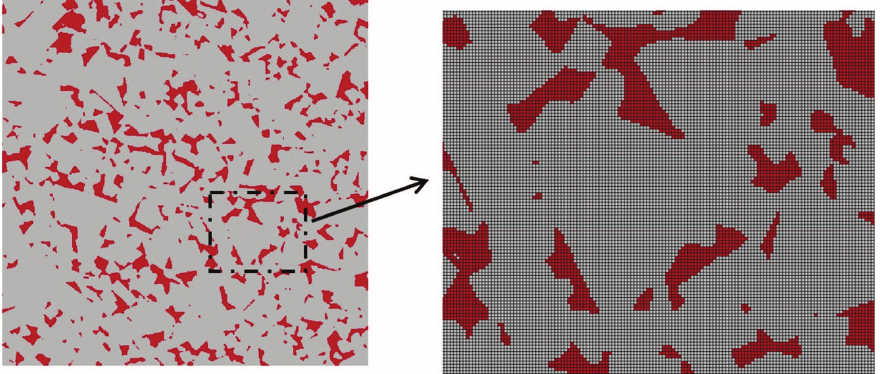
Figure 8: Finite element discretization of two-dimensional microgeometry including cobalt islands.